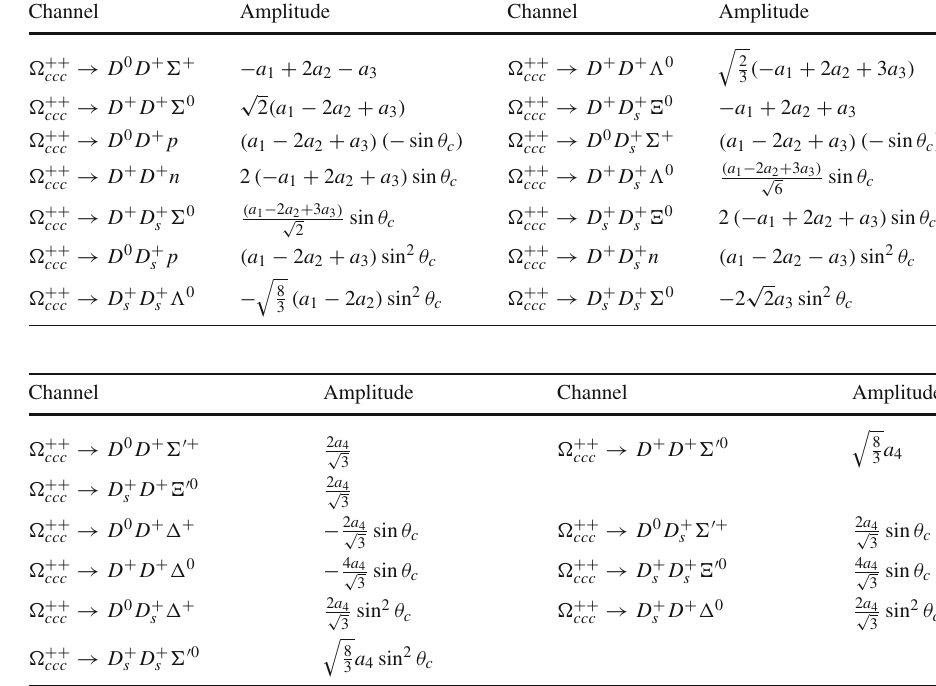
Channel Amplitude Channel